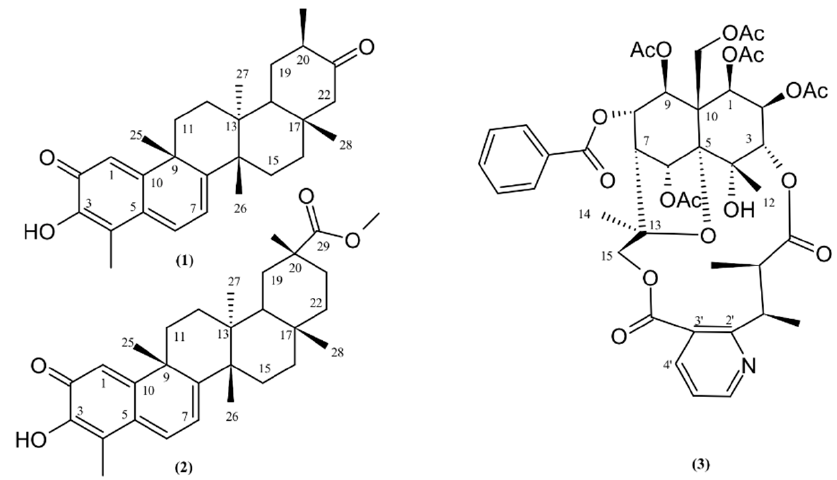
Figure 1. Structures of QMTs maytenin ( 1 ) and pristimerin ( 2 ) and the SPA aquifoliunin E1 ( 3 ) from Maytenus ilicifolia with carbons numbered accordingly.